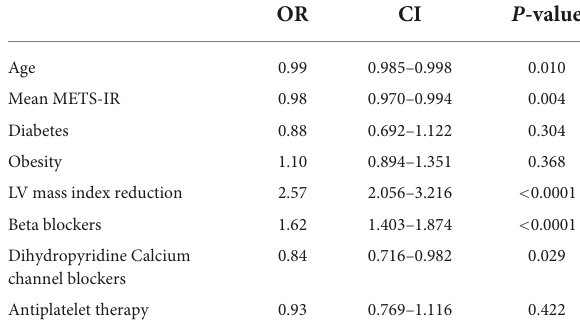
TABLE 3 Univariate regression analyses. TABLE 4 Logistic regression analysis performed for describing determinants of delta MEEi